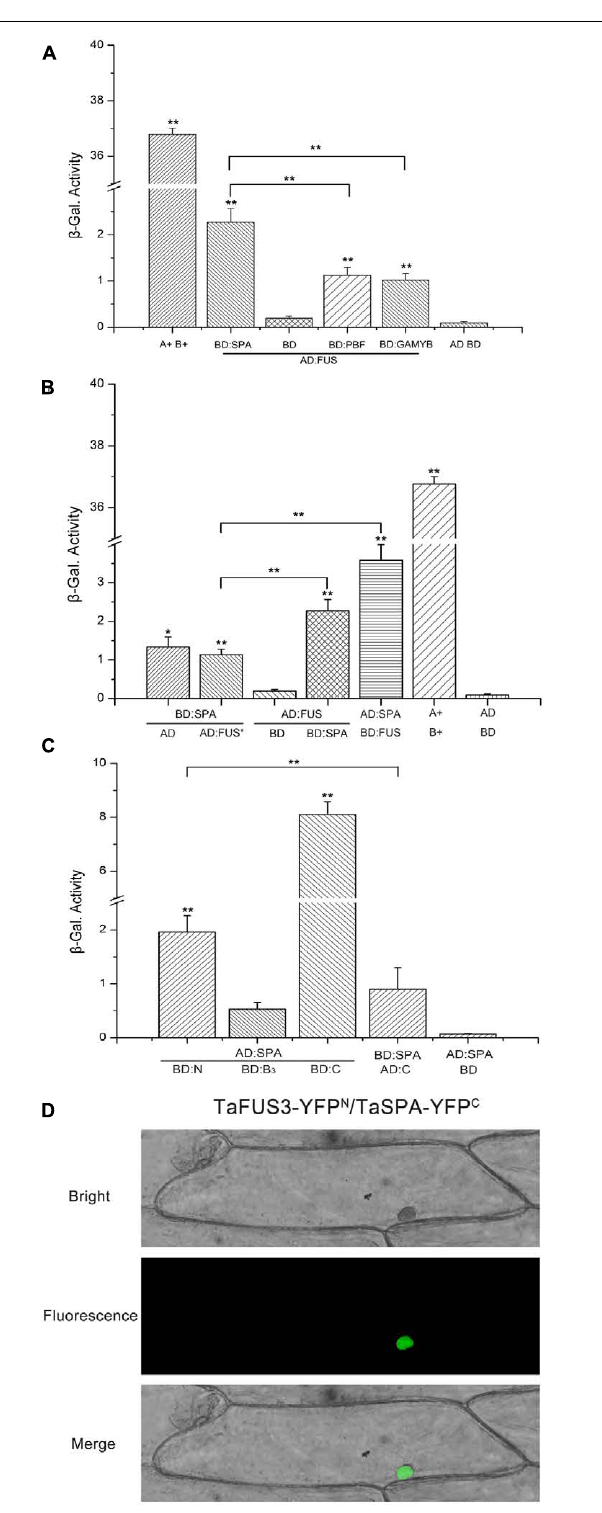
FIGURE 8 | Analysis of interactions between TaFUSCA3 and TFs related to wheat storage protein expression. (A) Interactions of TaFUSCA3 and TaSPA, TaPBF, and TaGAMYB in the Y2H system. The indicated effector constructs